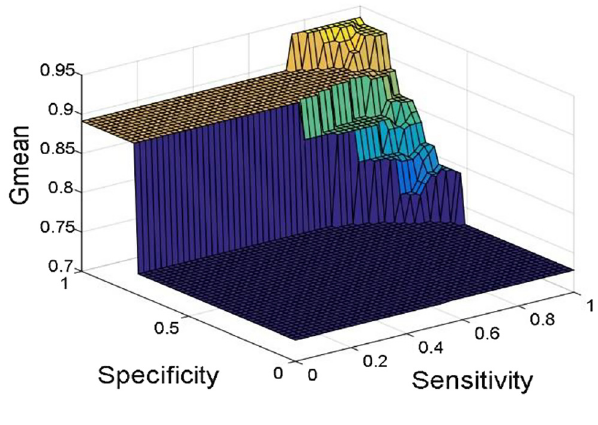
Figure 21: Sensitivity versus specificity versus Gmean (CJaya-ELM).